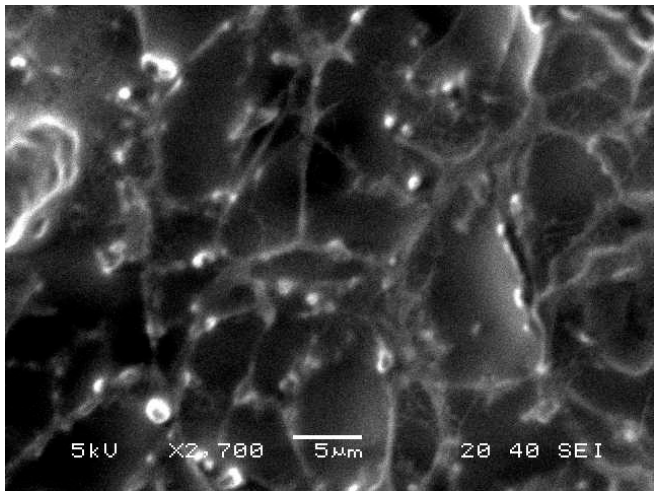
Figure 6. Scanning electron microscopy of BRU loaded ethosomal gel formulation.